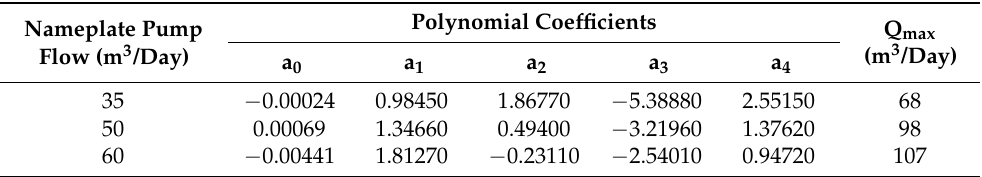
Table 1. ESP efficiency